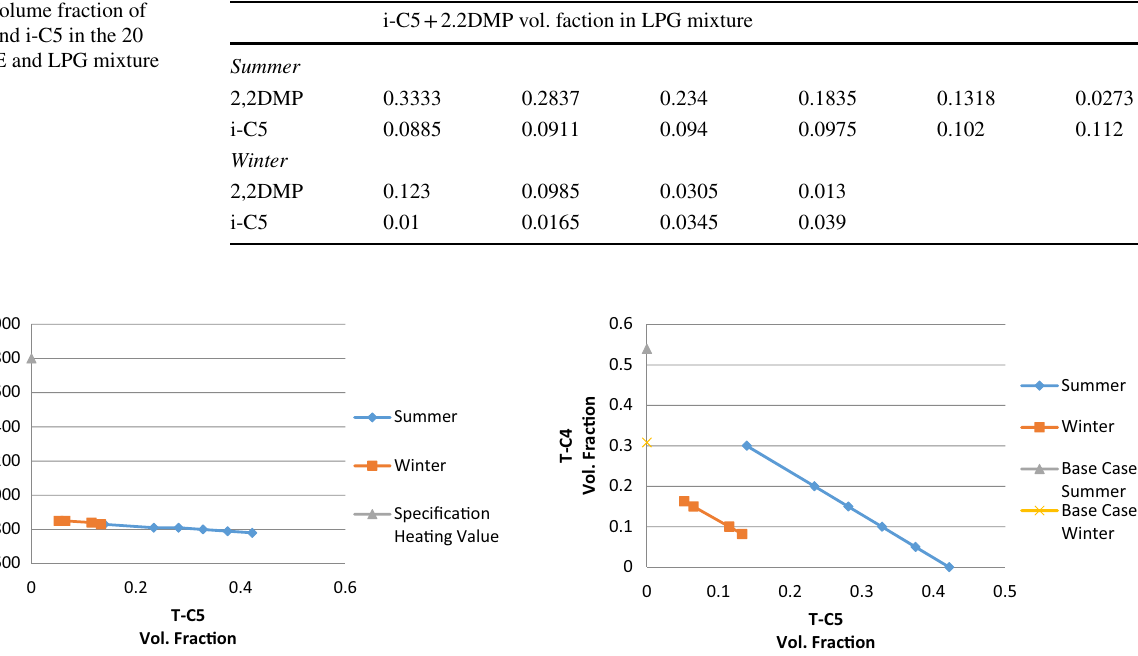
Fig. 42 Effect of adding i-C5, 2,2DMP and 20 vol% DME on LPG